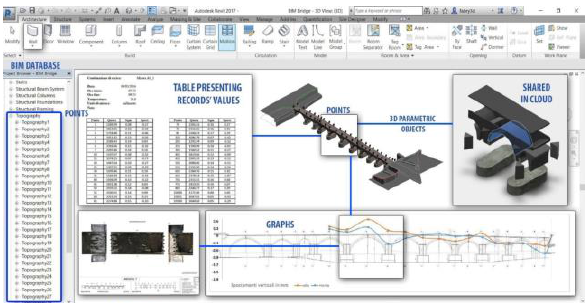
Figure 7: HBIM of the Azzone Visconti bridge including the model and the levelling results. (Banfi et al. , 2017)